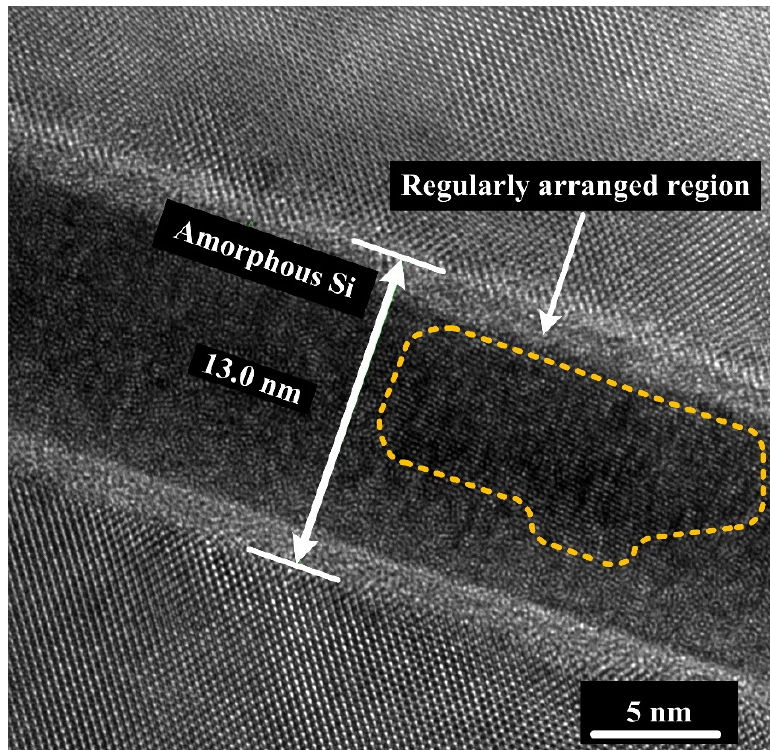
Figure 7. High-magnification cross-sectional TEM image (1.3 × 10 6 times) of the bonding interface in the bonded Si-Si specimen activated under the Ar ion beam current of 30 mA.